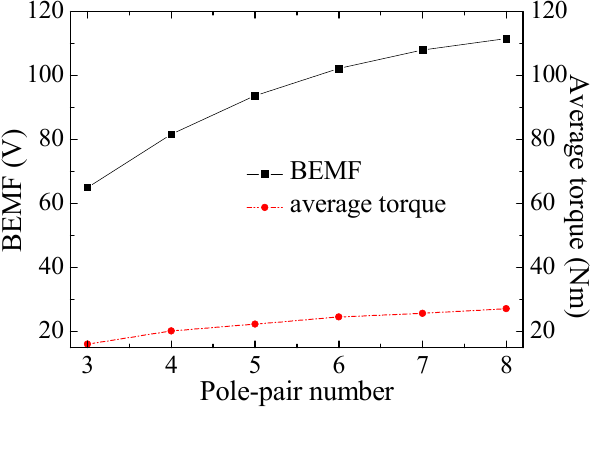
Figure 18. Variation of BEMF and average torque with the pole-pair number.